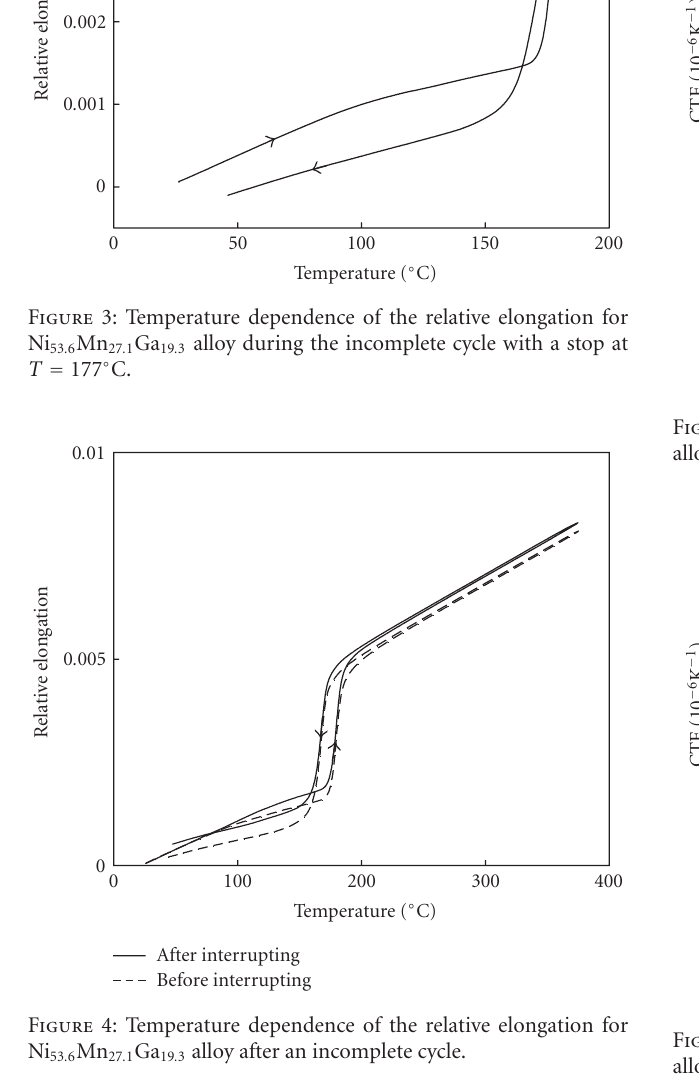
260 ◦ C, 261 ◦ C, and 265 ◦ C. The uninterrupted case is also shown in this figure.